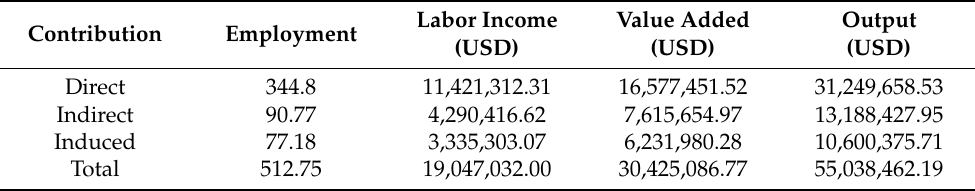
Table A8. Total Contribution of Rookery Bay to Lee and Collier Counties